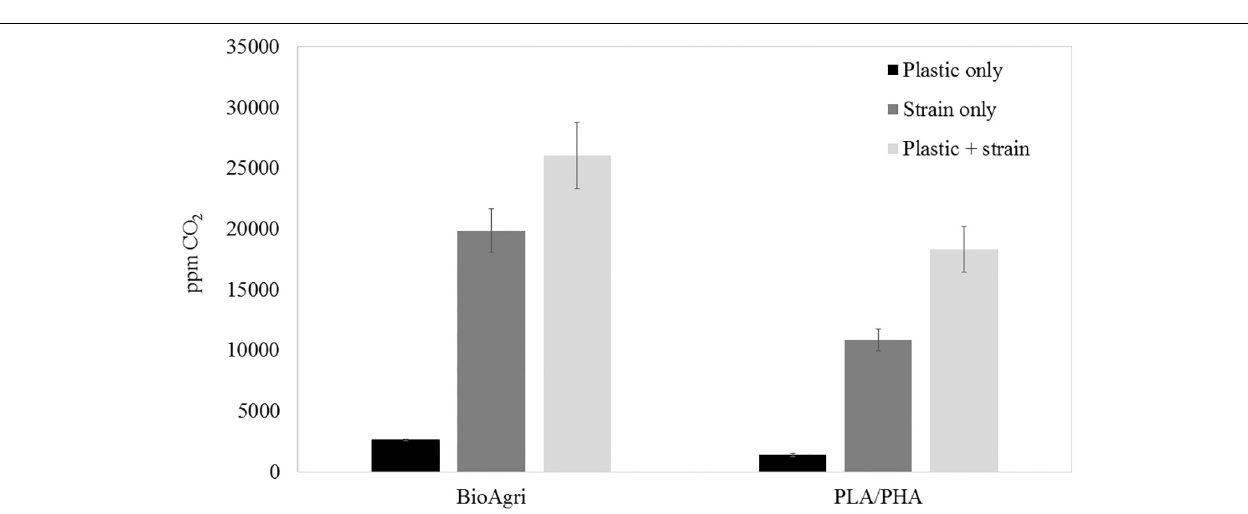
FIGURE 2 | Headspace CO 2 concentrations after 16 days of culturing Bacillus pumilus B12 in MSM with squares of biodegradable plastic mulch films. Data are means and standard deviations of triplicate culture